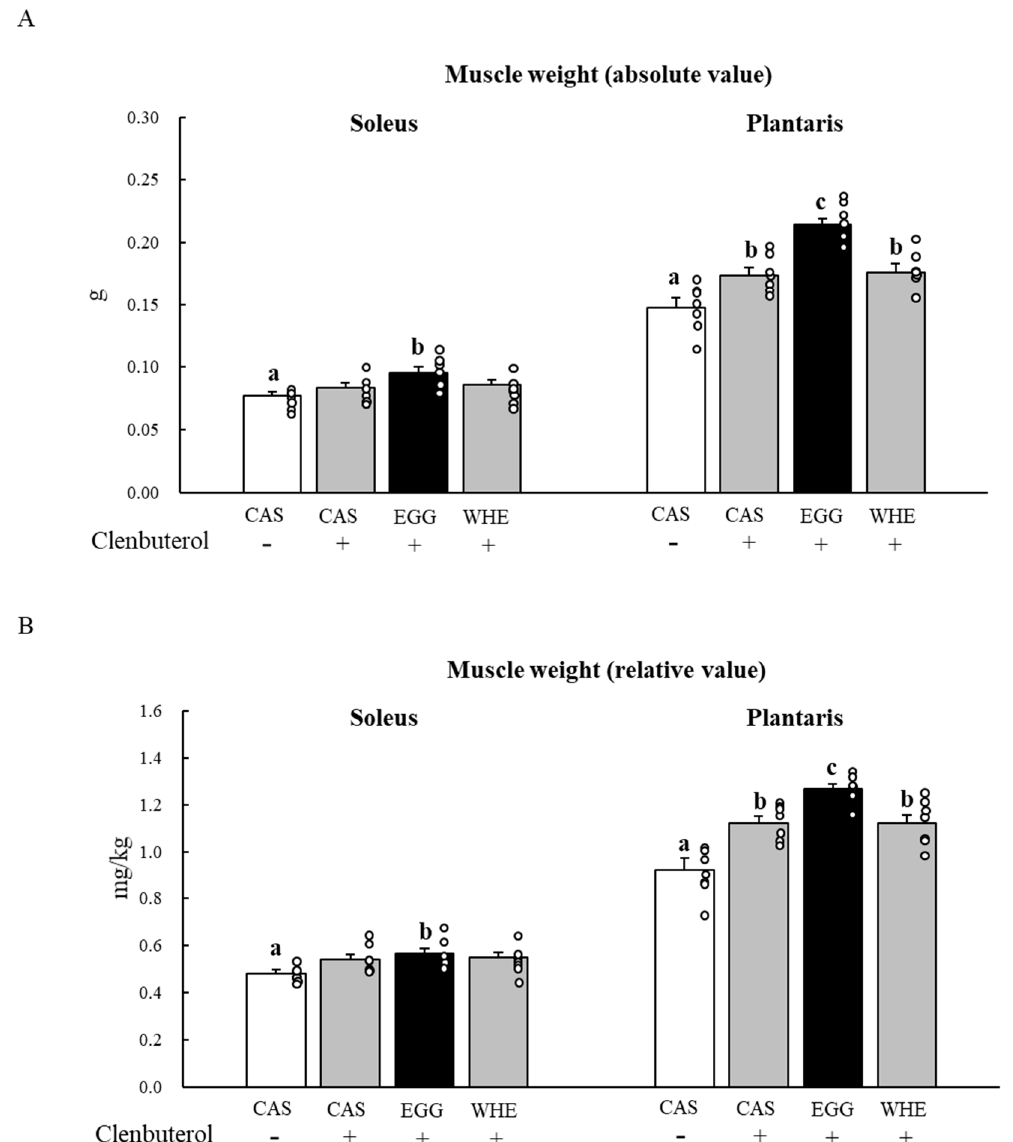
Figure 12. Chronic effect of each protein feeding on muscle weight (Day 7). Rats were assigned to either a casein, egg white, or whey protein diet group, and were maintained under ad libitum feeding for 7 days with or without clenbuterol administration. On day 7, rats were fasted for 6 h, and then muscles were dissected out. An absolute value ( A ) and a relative value to body weight ( B ) were calculated. The dots beside bars indicate individual value. Values are means ± SE ( n = 7). CAS: casein protein, EGG: egg white protein, WHE: whey protein. Different superscript represents statistical difference among groups in same muscle ( p < 0.05).